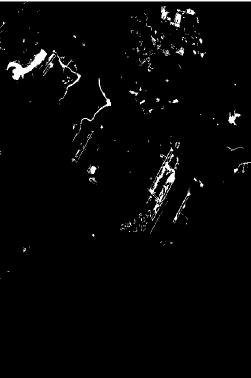
Figure 8. The water branch extraction result of data of Singapore from RADARSAT-2.